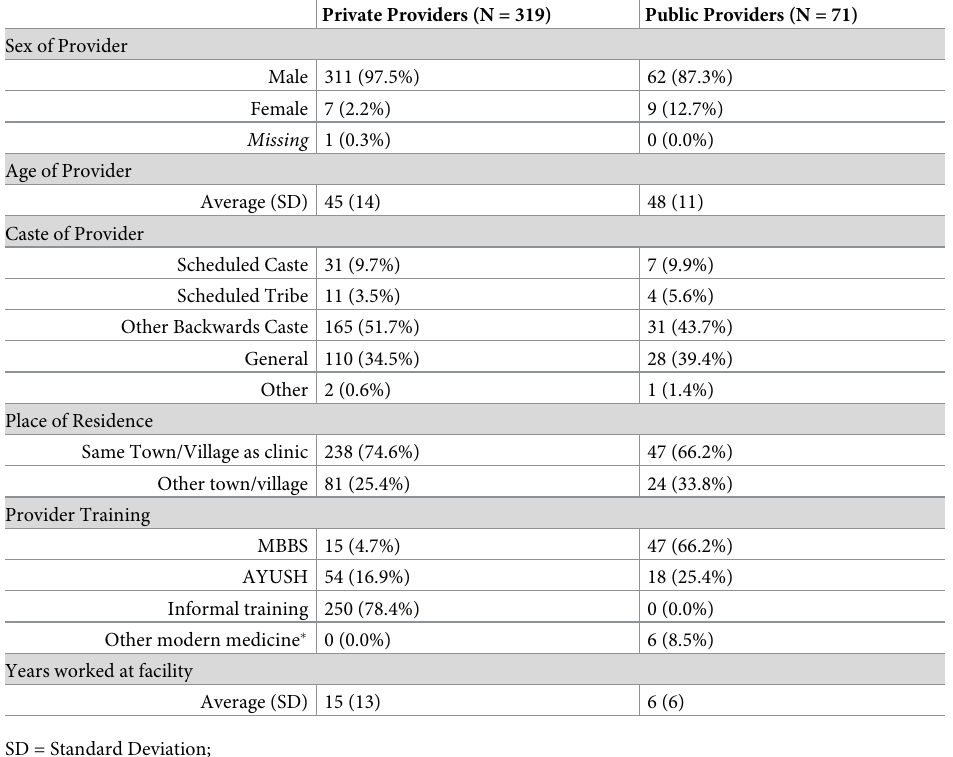
Table 2. Characteristics of providers (N =